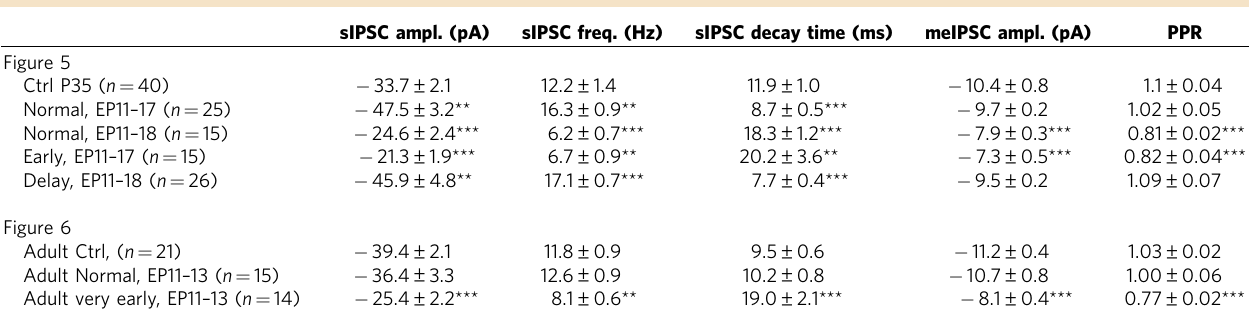
Figure 5 Ctrl P35 ( n ¼ 40)